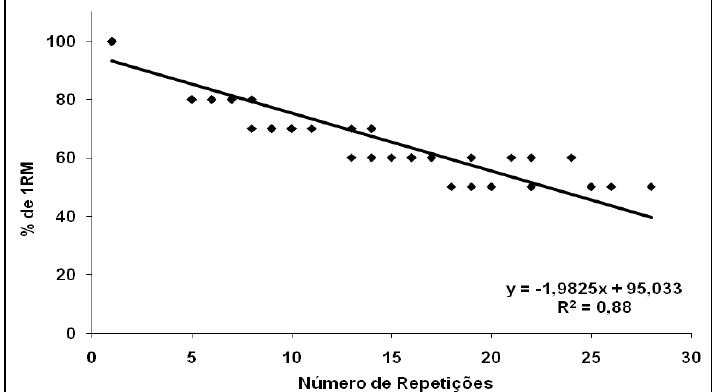
Figura 6. Relação entre o % de 1RM e o número de RMs atingido no